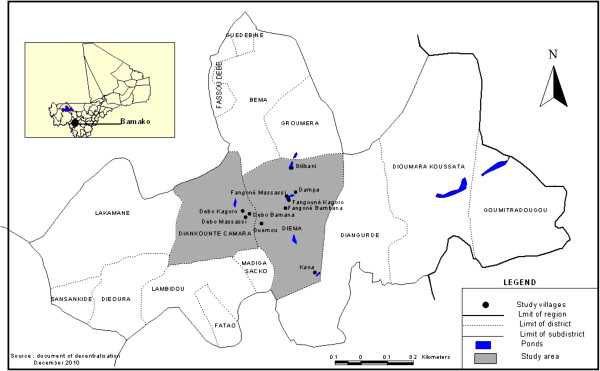
Localization of the ten study villages (*) in the district of Diéma, Mali.